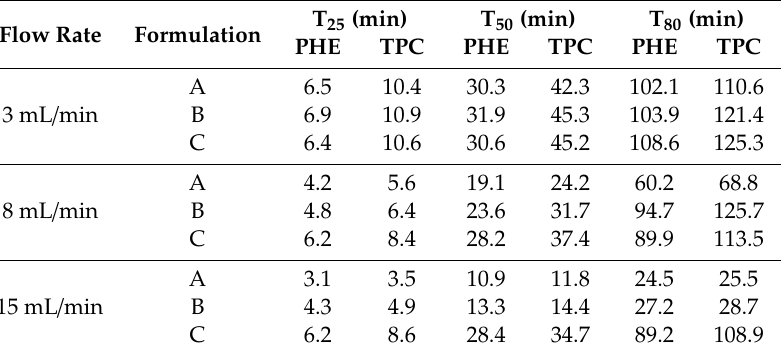
Table 6. T 25 , T 50 , and T 80 of formulations A, B, and C.